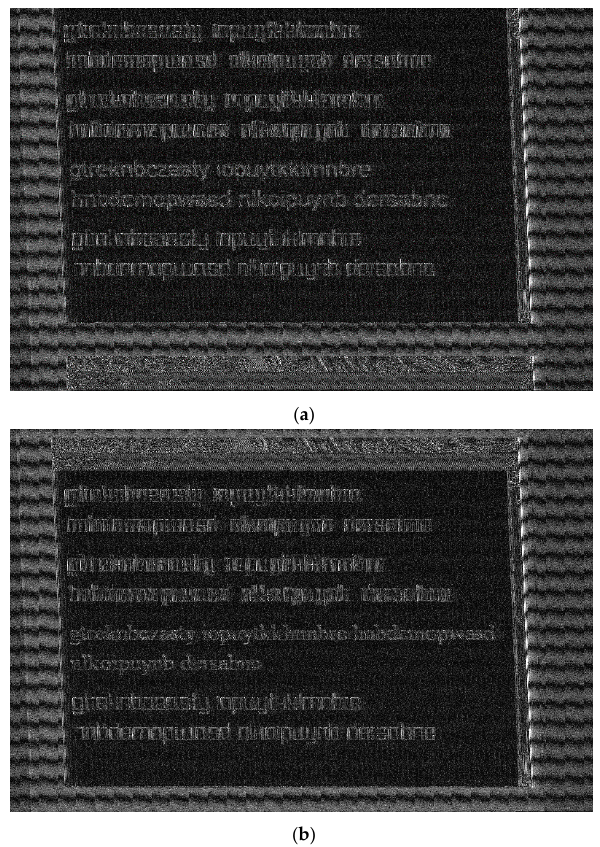
Figure 5. Reconstruction of the displayed image based on sensitive emissions measurement on frequency 840 MHz ( BW = 50 MHz, the size of characters—24 points): ( a ) from the top—secure symmetrical font, secure asymmetrical font, Arial font, ( b ) from the top—secure symmetrical font, secure asymmetrical font, Times New Roman font.